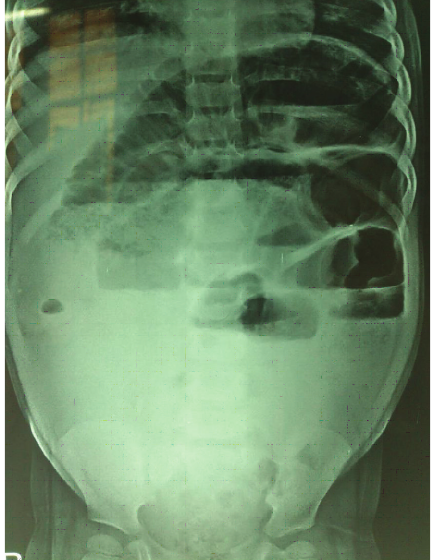
Figure 2: X-ray erect abdomen showing air fluid levels.